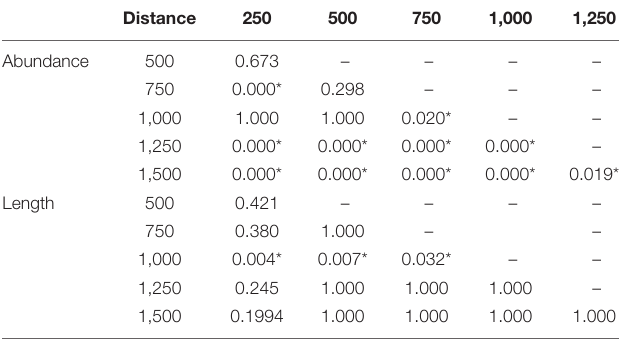
TABLE 1 | P -values of the Wilcoxon rank sum test